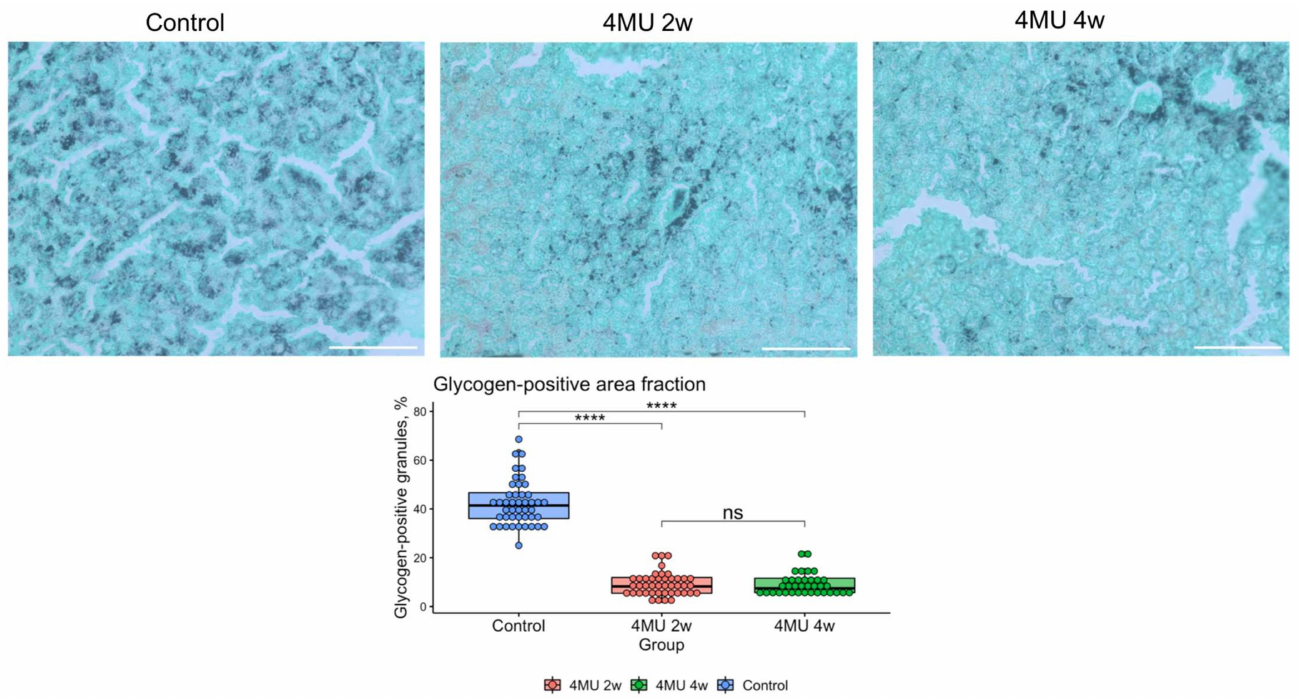
Figure 6. Glycogen granules in mouse hepatocytes after 4MU treatment. Gomori-Grocott methenamine silver staining of glycogen granules in mice hepatocytes after 2 (2w) and 4 weeks(4w) of 4MU treatment. In the figure, hepatocytes are light green and dark grey while glycogen granules are black. Scale bar—100 µ m. The plot represents the percentage of glycogen-positive area to total tissue area. Statistical difference was estimated by one-way ANOVA with Tukey post-hoc test (****— p .val < 0.0001; ns—not